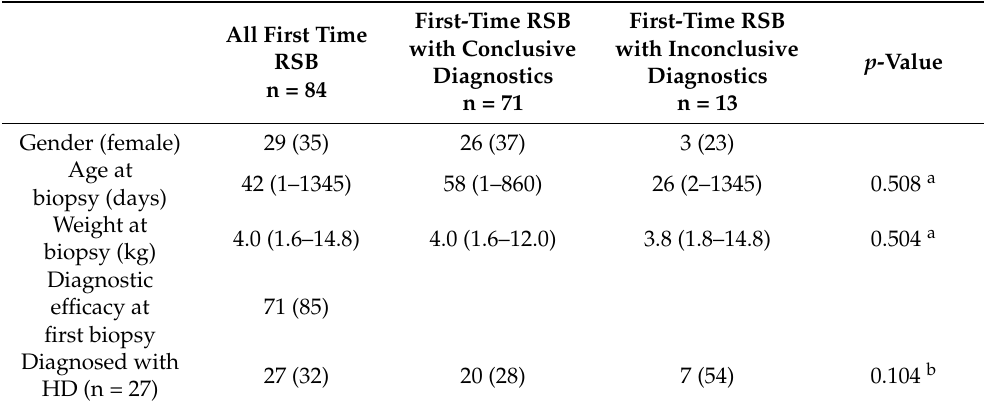
Table 1. Comparison of characteristics of 84 children with suspected Hirschsprung’s disease (HD) ex- amined with first-time rectal suction biopsy (RSB), with conclusive (specimen with identified submu- cosa) and inconclusive (specimen without identified submucosa) biopsies. n (%), median